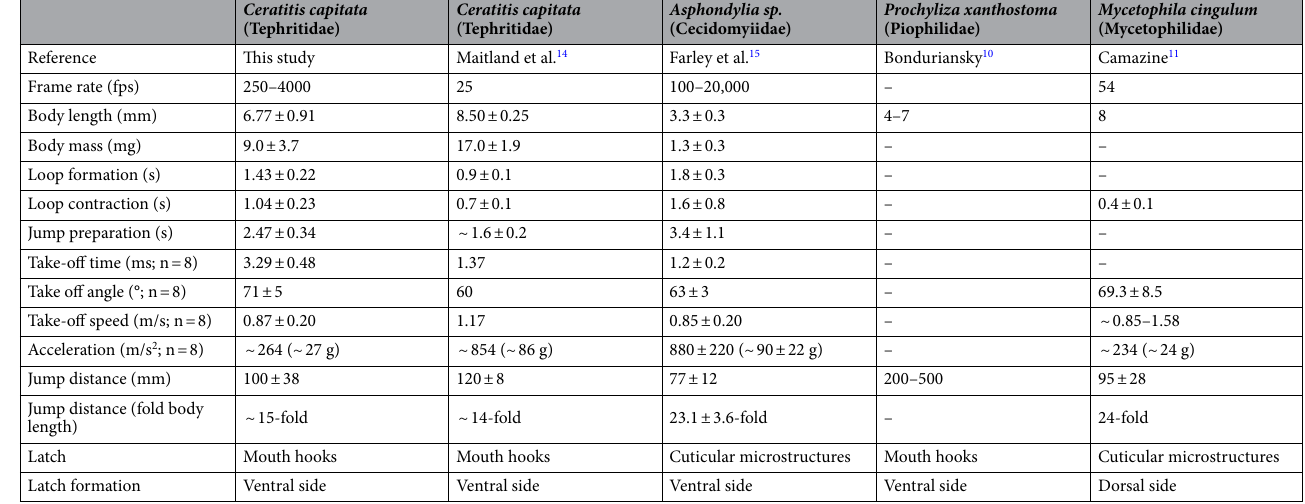
Table 1. Kinematic parameters of jumping dipteran larvae. Data are means ± s.d., if available. Dash, data not reported. Our study n = 40, except where